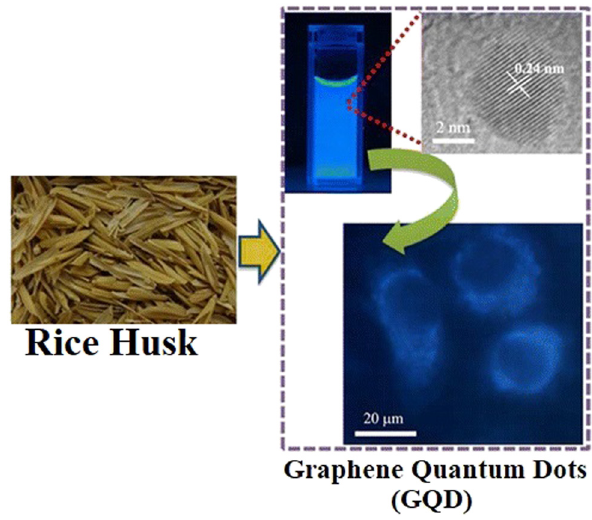
Figure 8: Proposed synthesis for powder GQDs by the hydrolysis method and corresponding TEM imaging. Copyright © 2016, ACS Publishing Group [ 188 ] .